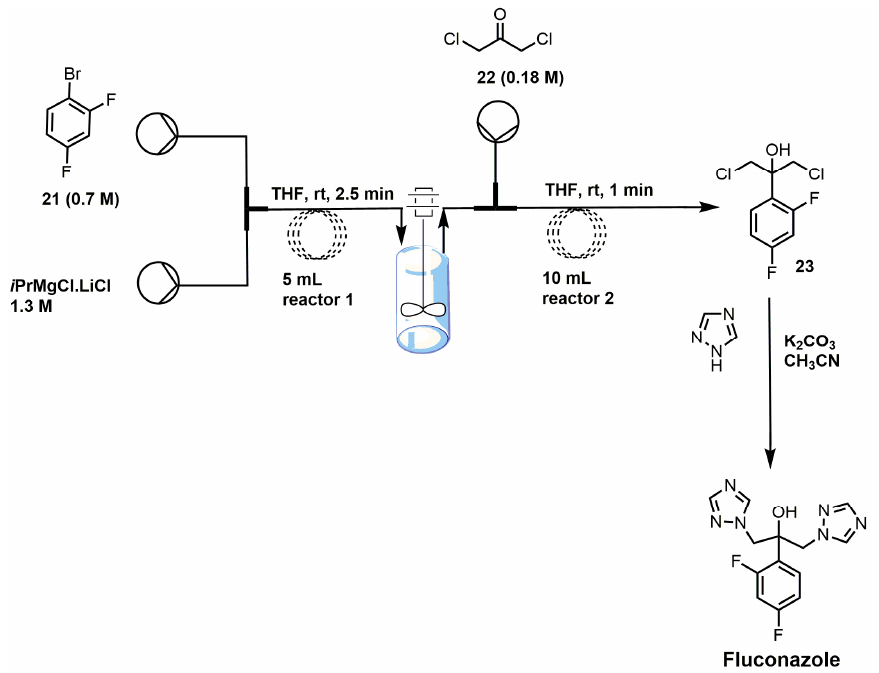
Figure 12. Synthesis of fluconazole using flow-injection methodology (adapted from [39]).